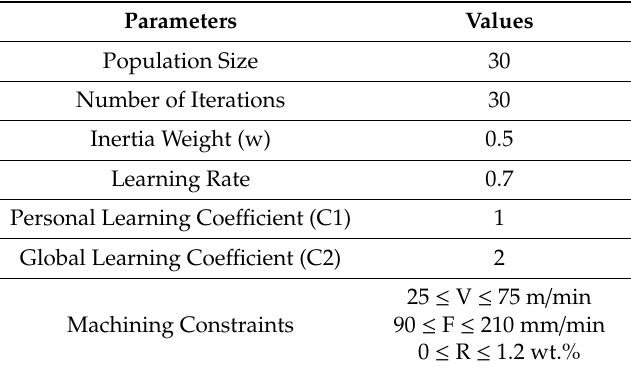
Table 10. Parameters of MOPSO and machining